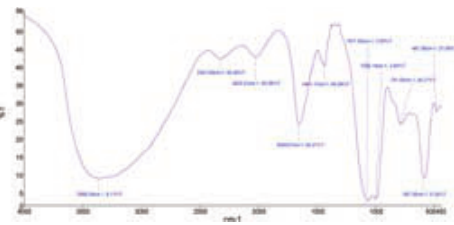
Figure 7: Infrared spectrum from goat A showing struvite bands at 3500-3350, 1434, 2346, 1and 1000.48 cm -1